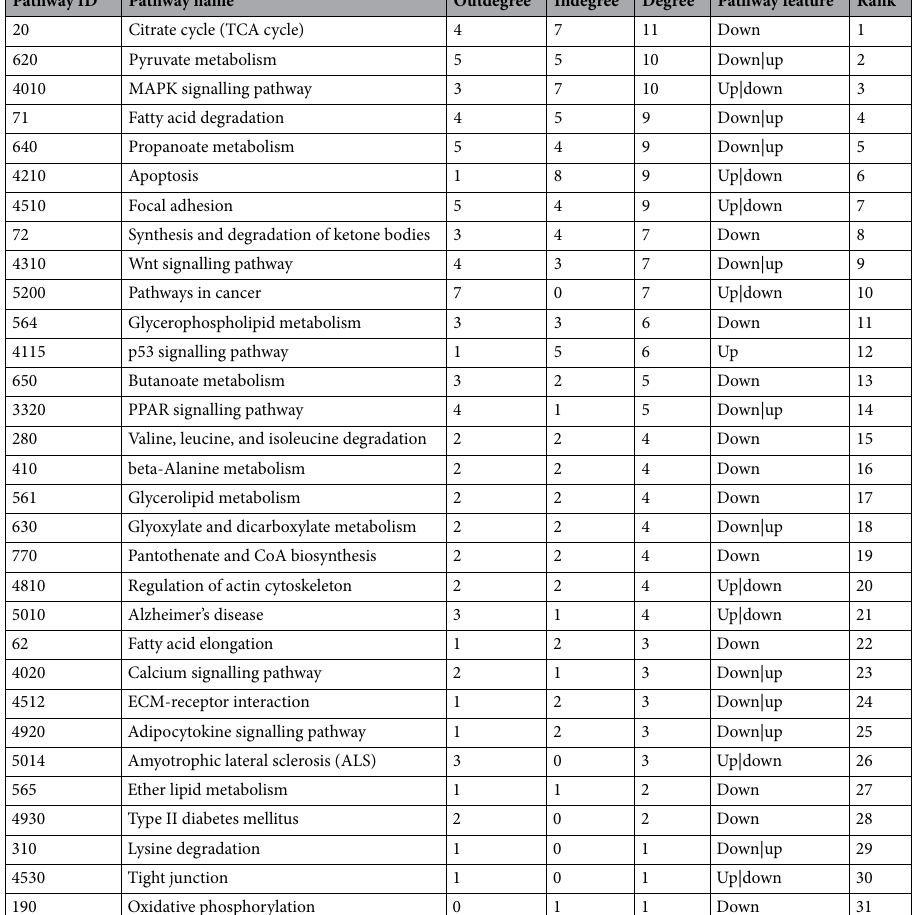
Table 4. Core pathways identified from pathway network analysis (in order of decreasing